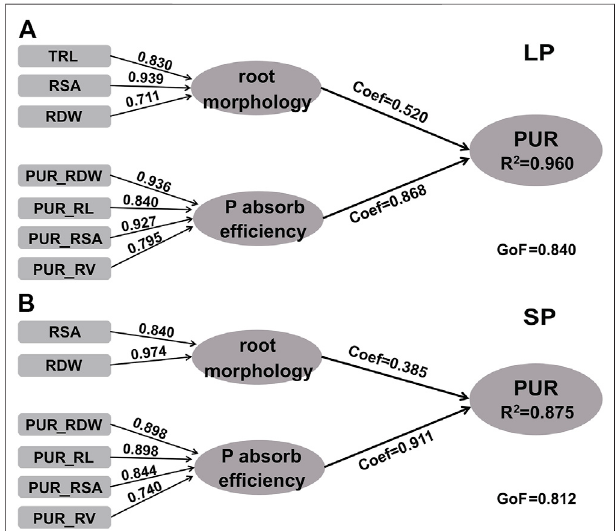
FIGURE5 | Partial least square-path models predictingPUR. (A) Low-P (LP) condition and (B) suf fi cient-P (SP) condition. Coef is the path coef fi cient. GoF, goodness of fi t of the model; R 2 , coef fi cients of determination of the endogenous latent variables; RDW, root dry weight per plant; TRL, total toot length; RSA, root surface area; RV, root volume; ARD, average root diameter; RTN, root tip number; SRL, speci fi croot length; PUR, P uptake rate per plant; PUR_RDW, P uptake rate per unit root dry weight; PUR_RL, P uptakerateper unitrootlength;PUR_RSA,Puptake rateper unitroot surface area;PUR_RV,Puptakerateper unit rootvolume. Coef aresigni fi cantat 95% con fi dence intervals ( p value <